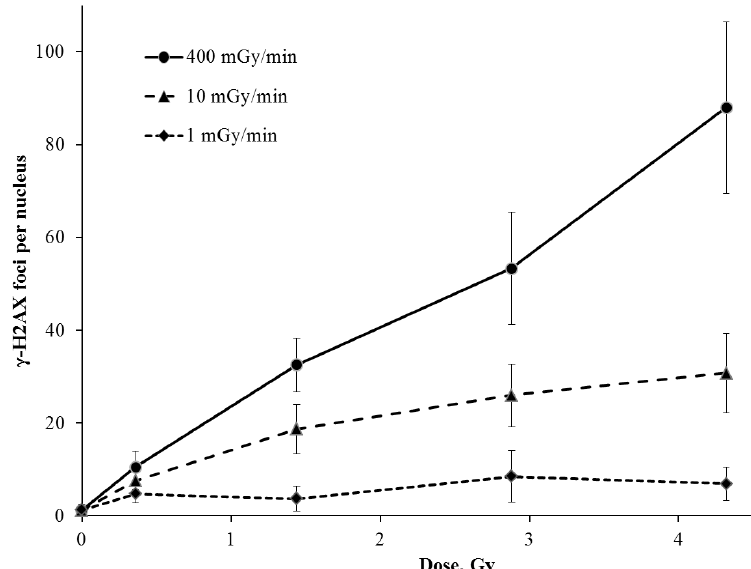
Figure 1. The yield of γ-Н2АХ foci in Chinese hamster V79 cells exposed to γ-rays